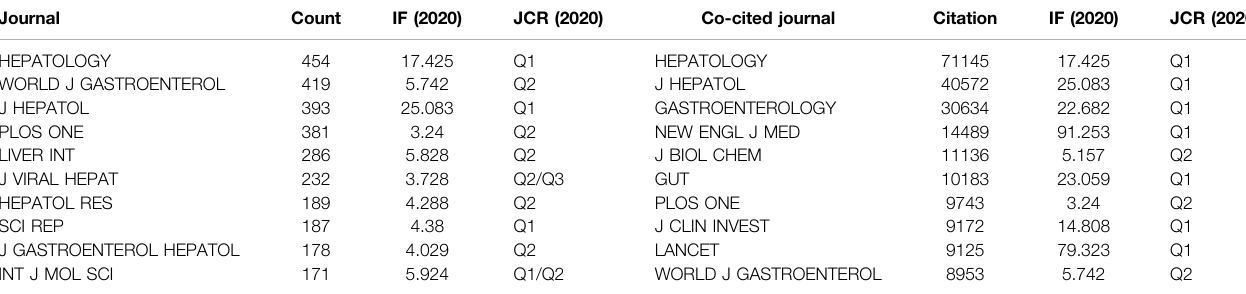
TABLE 2 | The top 10 journals and co-cited journals associated with the treatment of liver fi